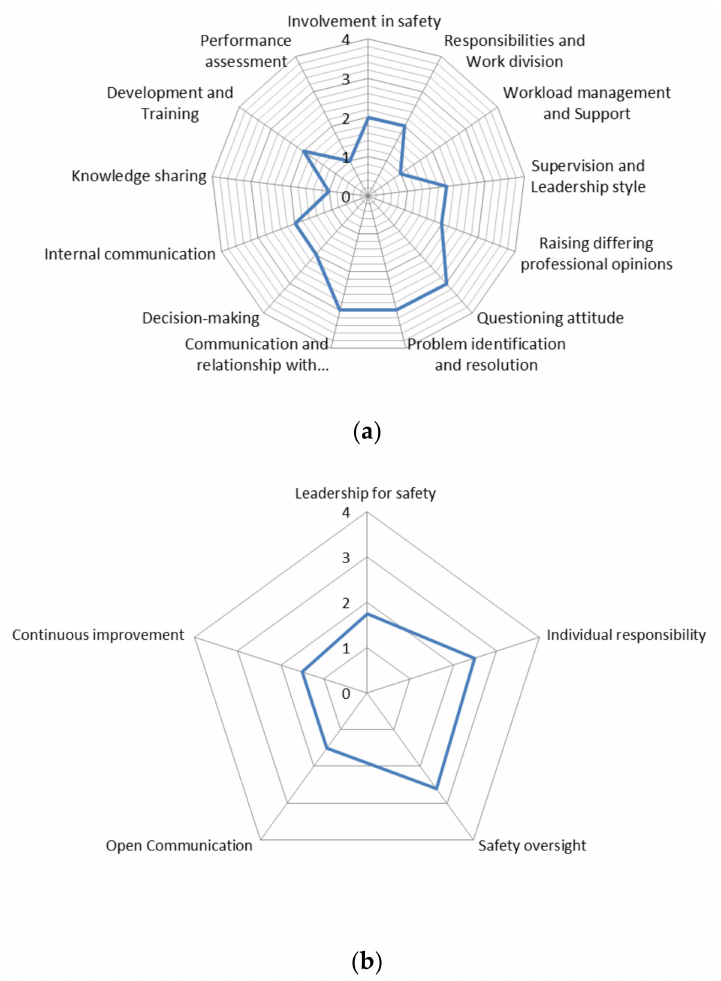
Figure 2. ( a ) Examples of radar graphs (overall view). ( b ) Examples of radar graphs (arithmetic